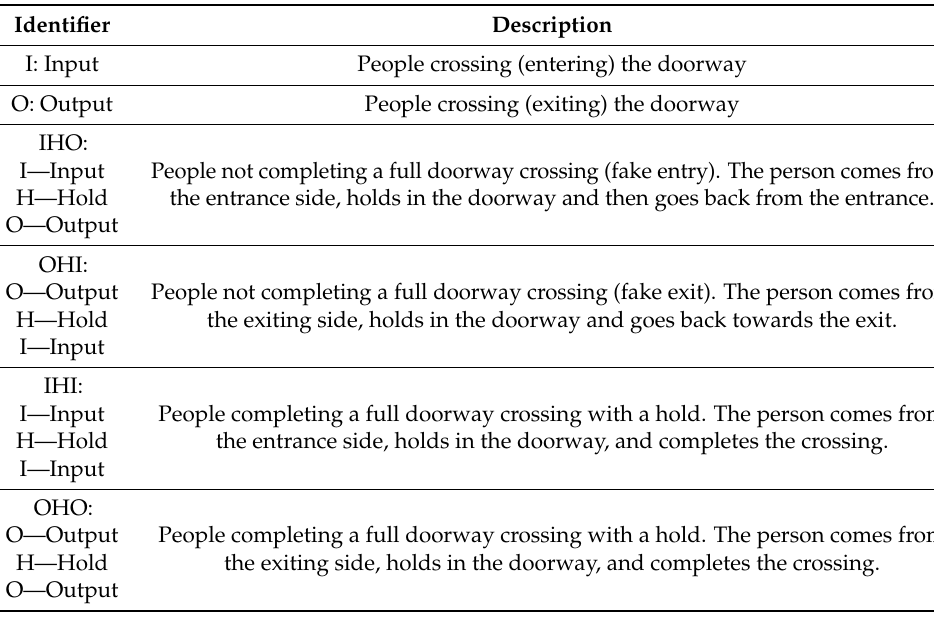
Table 3. The description of various events: actions performed by the